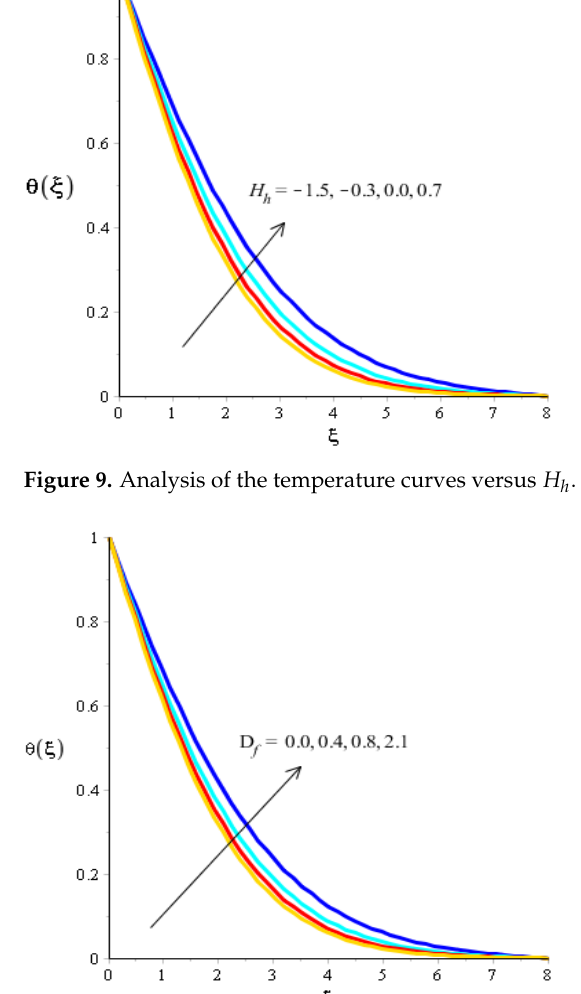
Figure 10. Analysis of the temperature curves versus 𝐷 (cid:3033) .